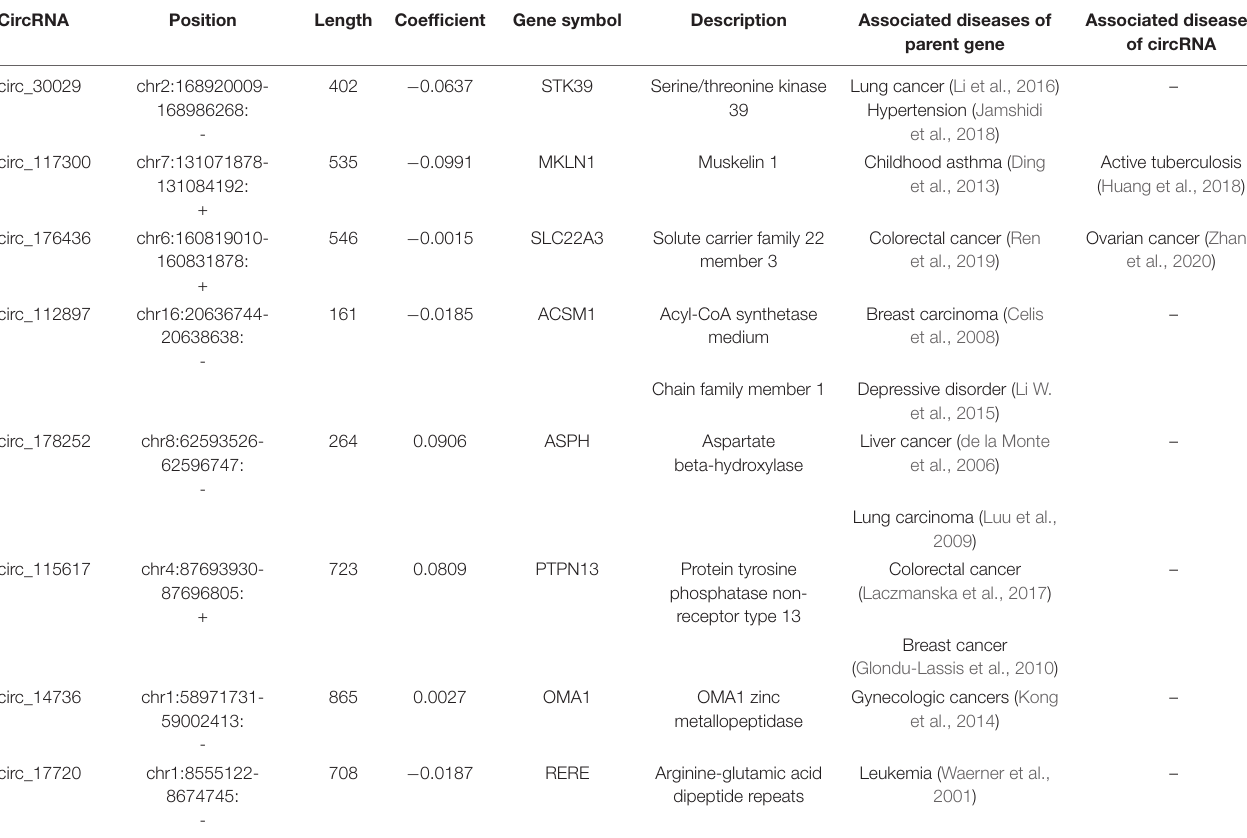
TABLE 2 | CircRNAs significantly associated with the biochemical recurrence free survival in the test series patients ( N = 144).